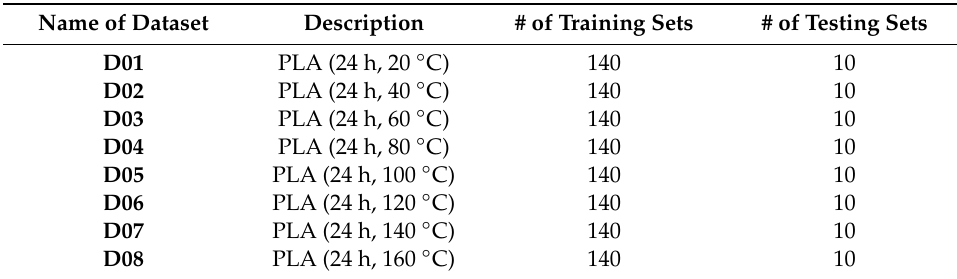
Table 1. Description of Fourier transform infrared (FTIR) datasets.